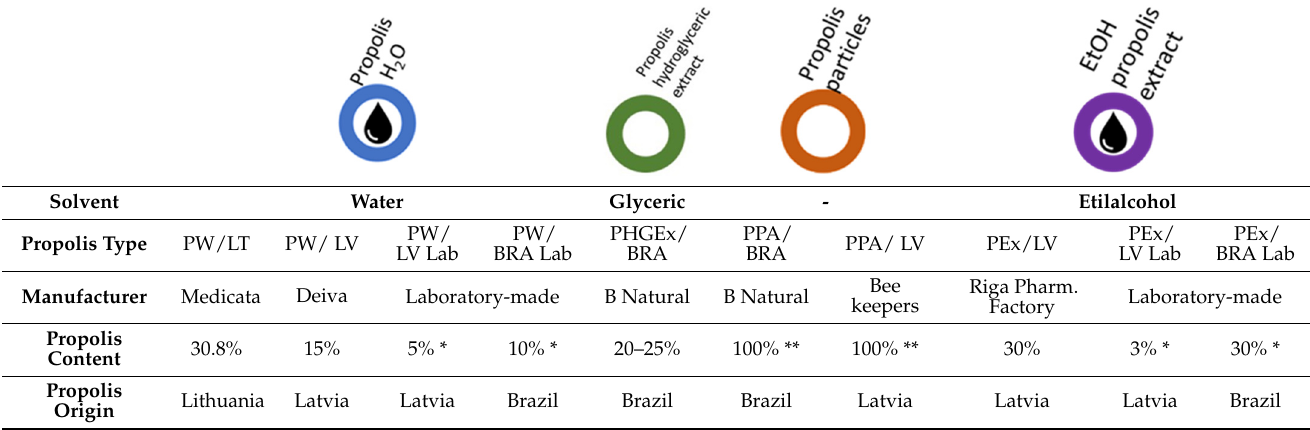
Figure 3. The components of electrospinning solutions and designations of solution-mixing process stages. 3.2. Characterizations of Fiber Webs and Solutions To assess the suitability of the prepared solutions for electrospinning, the density (using an aerometer), conductivity (conductometer Greisinger GLF-100, Regenstauf, Ger- many), viscosity (Viscosiometer Viscolead adv, Fungilab S.A.,100 rpm, used tip L6), and pH (pH/ORT Tester AD14, ADWA Instruments, Bucarest, Hungary) of each solution and propolis extract were determined at 20 ± 0.15 °C. The homogeneity of the spinning solu- tions was analyzed by Stereo Zoom Microscope (Motic SMZ-171, Xiamen, China). Elec- trospun Fibers quality and diameters were analyzed from micrographs obtained by scan- ning electron microscope (SEM Mira Tescan, Bern, Czech Republic), before covered with a gold coating (5–20 nm). The image analysis program ImageJ was used for diameters measurements (at least one hundred measurements at five different locations for each sample). Total flavonoid contents in propolis and fiber webs were determined with a UV- VIS spectrophotometer (Perkin Elmer Lamda 650, Waltham, MA, USA). 3.3. Propolis Extracts Preparation To prepare the laboratory-made propolis water, 20 g of powder is added to 200 mL of water and boiled for 20 min to remove the Arabic Gum or beeswax. The proportions of water and propolis are in accordance with the requirements for the determination of bees- wax in propolis [24]. Further, the solution is filtered through Nr. 398 cellulose filter and allowed to stand for 5 days. The liquid with the resin is poured off, and propolis water PW/BRA Lab solution is obtained (PW/LV Lab samples are prepared with the same method using raw propolis with a wax content of 25%, which was separated after boiling). The propolis placed at the bottom of the vessel is poured with ethyl alcohol and stirred for 30 min to obtain PEx/BRA Lab extract; see mixing sequence Figure 4. Propolis extracts